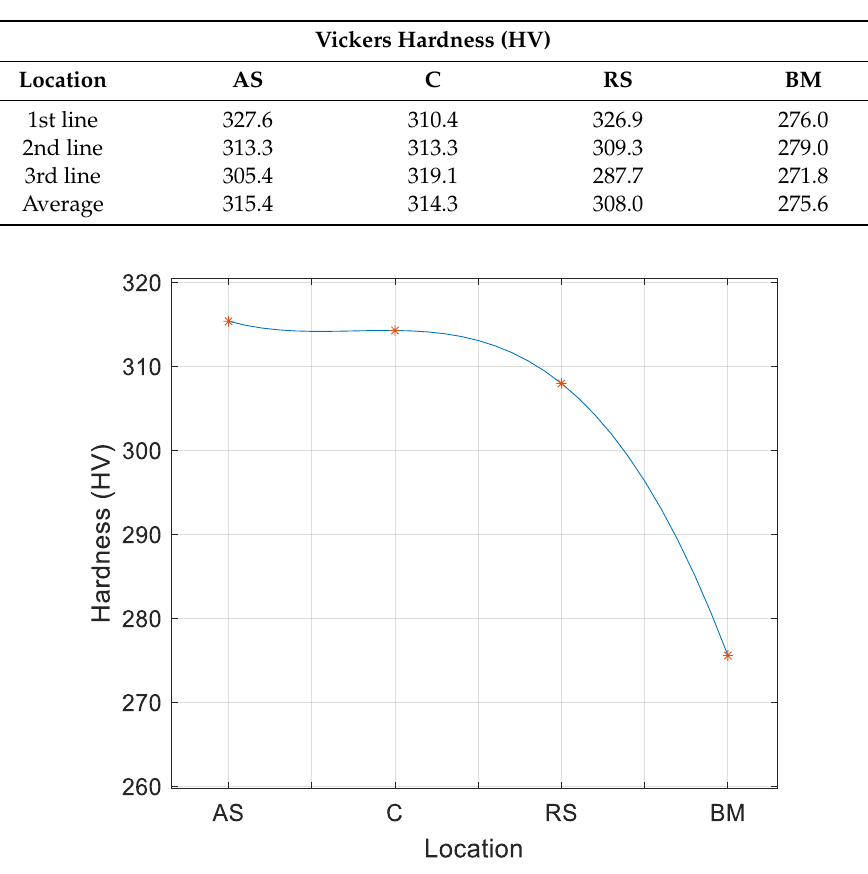
Figure 13. Hardness profile for SZ and BM 2507 SDSS.